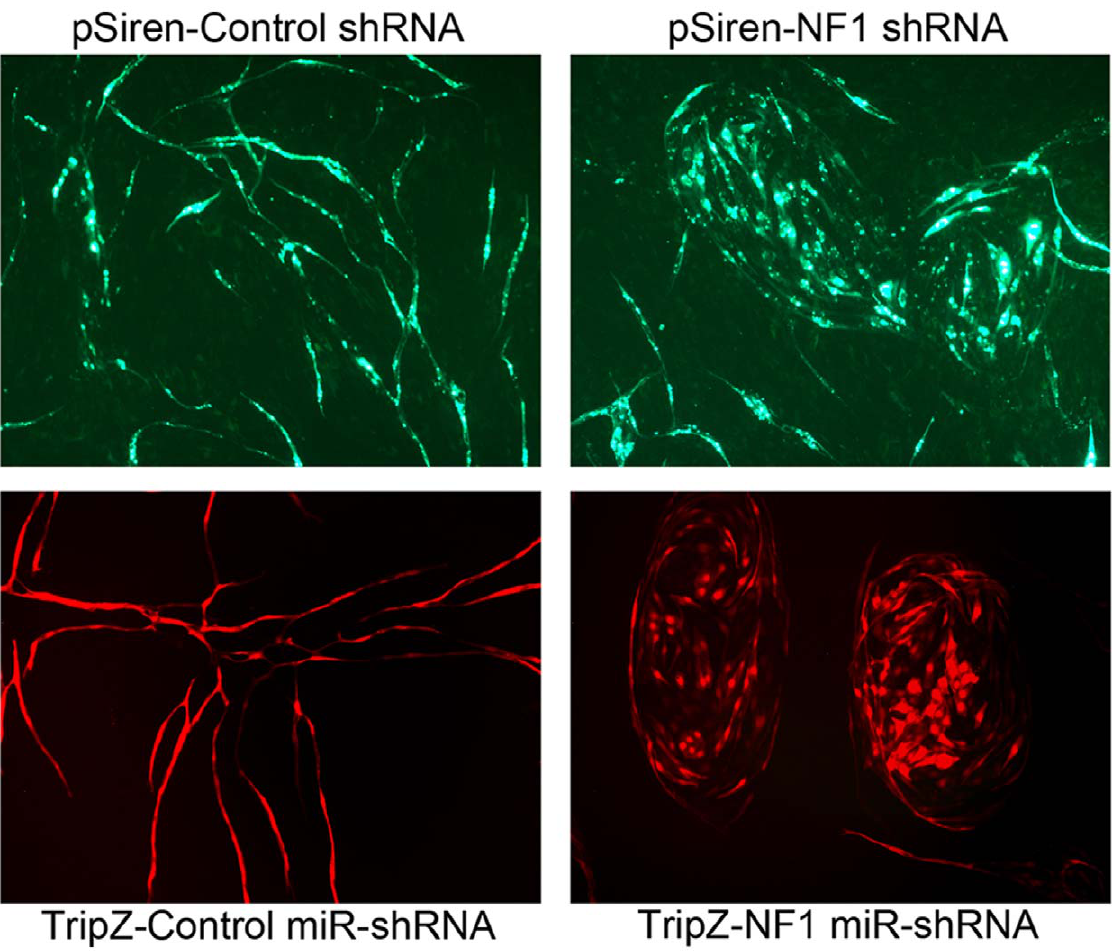
Figure 3. Loss of NF1 expression results in abnormal vascular morphogenesis. Top Panel - Primary endothelial cells infected with non- targeting pSIREN lentivirus (Control) or one directed toward knockdown of NF1 (NF1-KD). These cells were plated with primary fibroblasts in an admixed co-culture. After 14 days, endothelial cells were visualized by the vector expressed GFP. Bottom Panel - Endothelial cells infected with TRIPZ- Control or NF1miR-shRNA, were plated in co-culture with primary fibroblasts in the presence of doxycycline to induce expression of shRNA and RFP. Vascular structures were visualized at day 14 using RFP co-expressed in the endothelial cells.